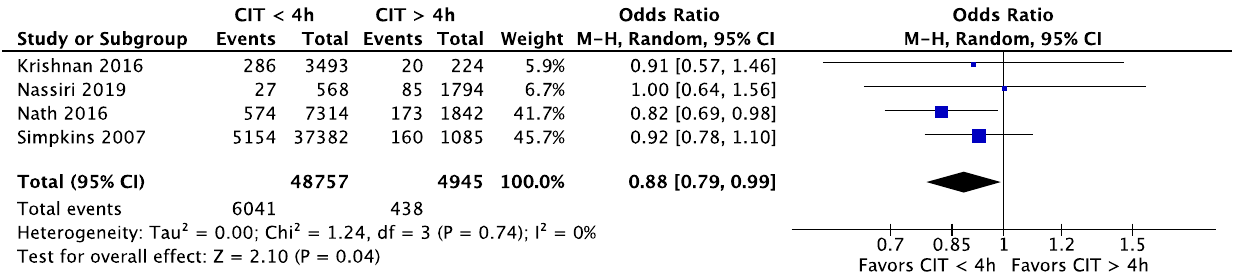
Figure 7. Five-year graft survival for CIT shorter and longer than 4 h. CIT: cold ischaemia time.